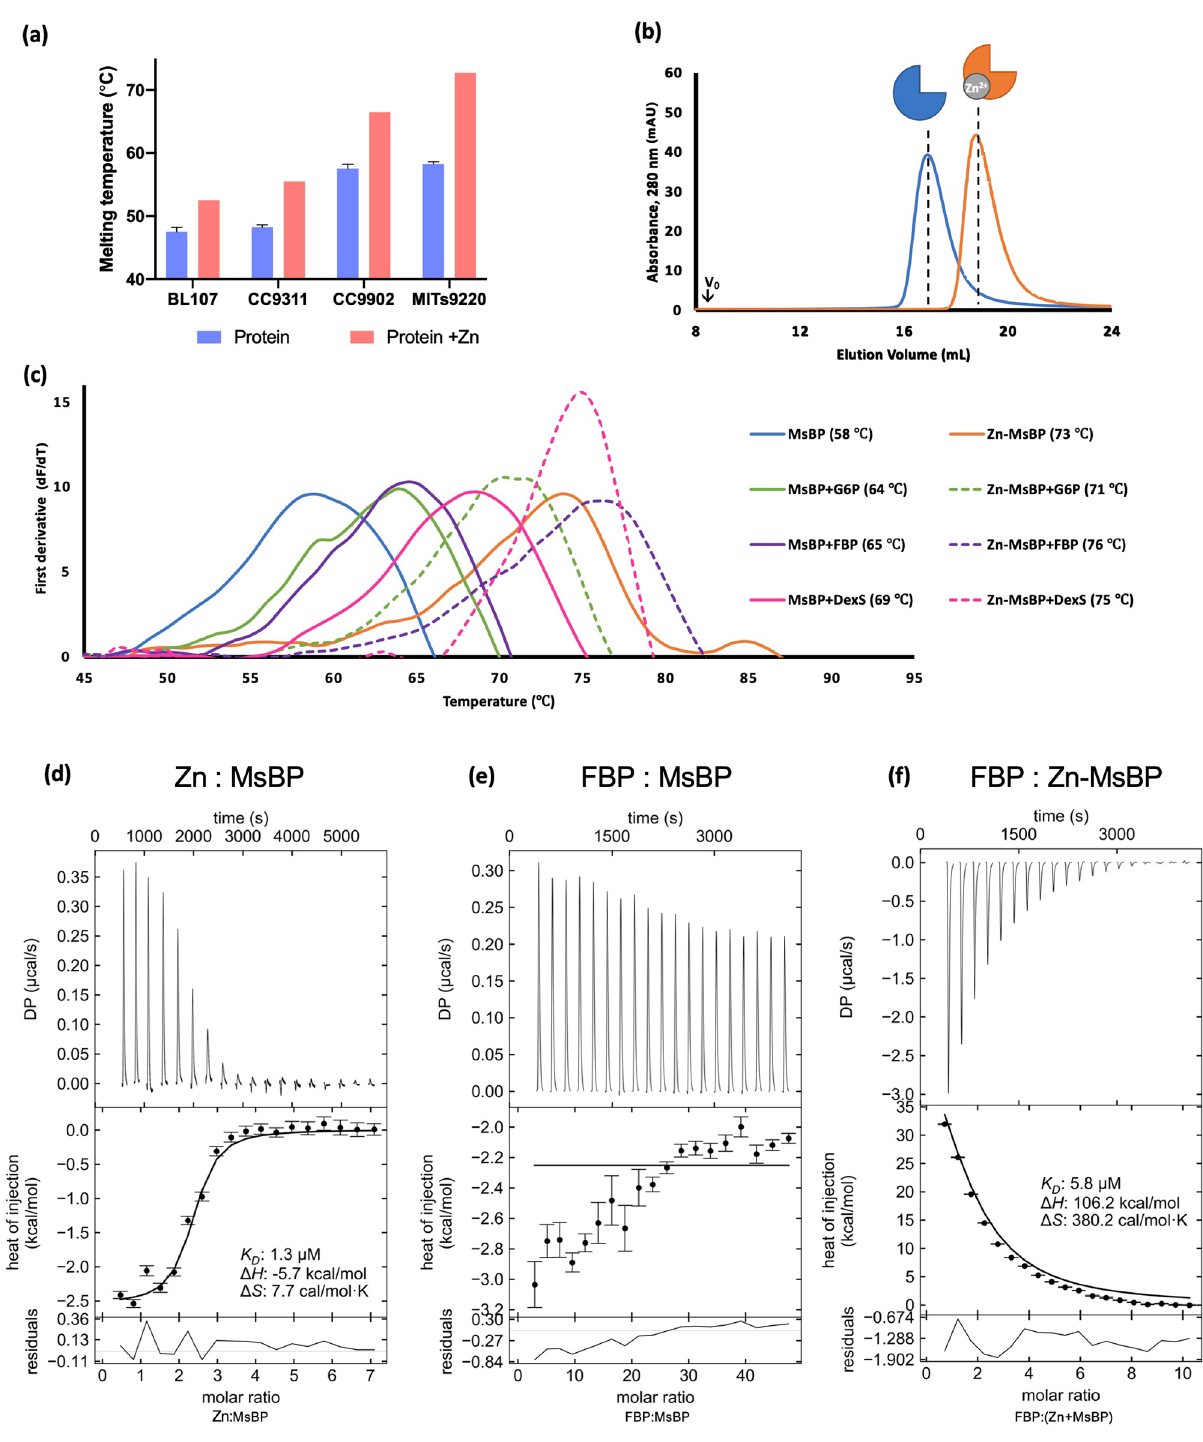
Figure 2. Solution characterisation of MsBP and orthologues. (a) Melting temperature of representative CK_1342 proteins in the presence and absence of Zn 2+ highlighting the additional thermal stability conferred by Zn 2+ . (b) Analytical SEC highlighting the observed retention volume of MsBP (blue) and its corresponding derived M R (consistent with a monomeric distribution), which was retarded upon adding Zn 2+ (Zn-MsBP, orange) seen by the shift in observed retention volumes on a Superdex 200 10/300 GL column made of agarose-dextran composite. (c) Ligand screening (fluorescence response) of MsBP was obtained (blue), identifying a high-affinity interaction with Zn 2+ (Zn-MsBP, orange), and selected sugar derivatives glucose-6-phosphate (G6P, green), fructose- 1,6-bisphosphate (FBP, purple), and dextran sulphate digest (DexS, pink). Dashed lines indicate a condition in the presence of Zn 2+ . Curves are presented as the first derivatives of fluorescence response and temperature (dF/dT), where peak maxima correspond to T M . Analytical SEC procedures utilised an AKTA Pure, operating at 0.5 mL min -1 with a Superdex 200 10/300 column. Columns were equilibrated in HEPES buffer (50 mM, pH 7.4), containing NaCl (300 mM) and glycerol (5% v/v). Void volumes for each SEC trace are indicated (V 0 ). ITC studies of purified MsBP titrated with (d) zinc, (e) fructose-1,6-bisphosphate and (f) fructose-1,6-bisphosphate after pre-incubation with Zn 2+ (Zn-MsBP). The heat of injection (kcal/mol) in all cases represents per mol of